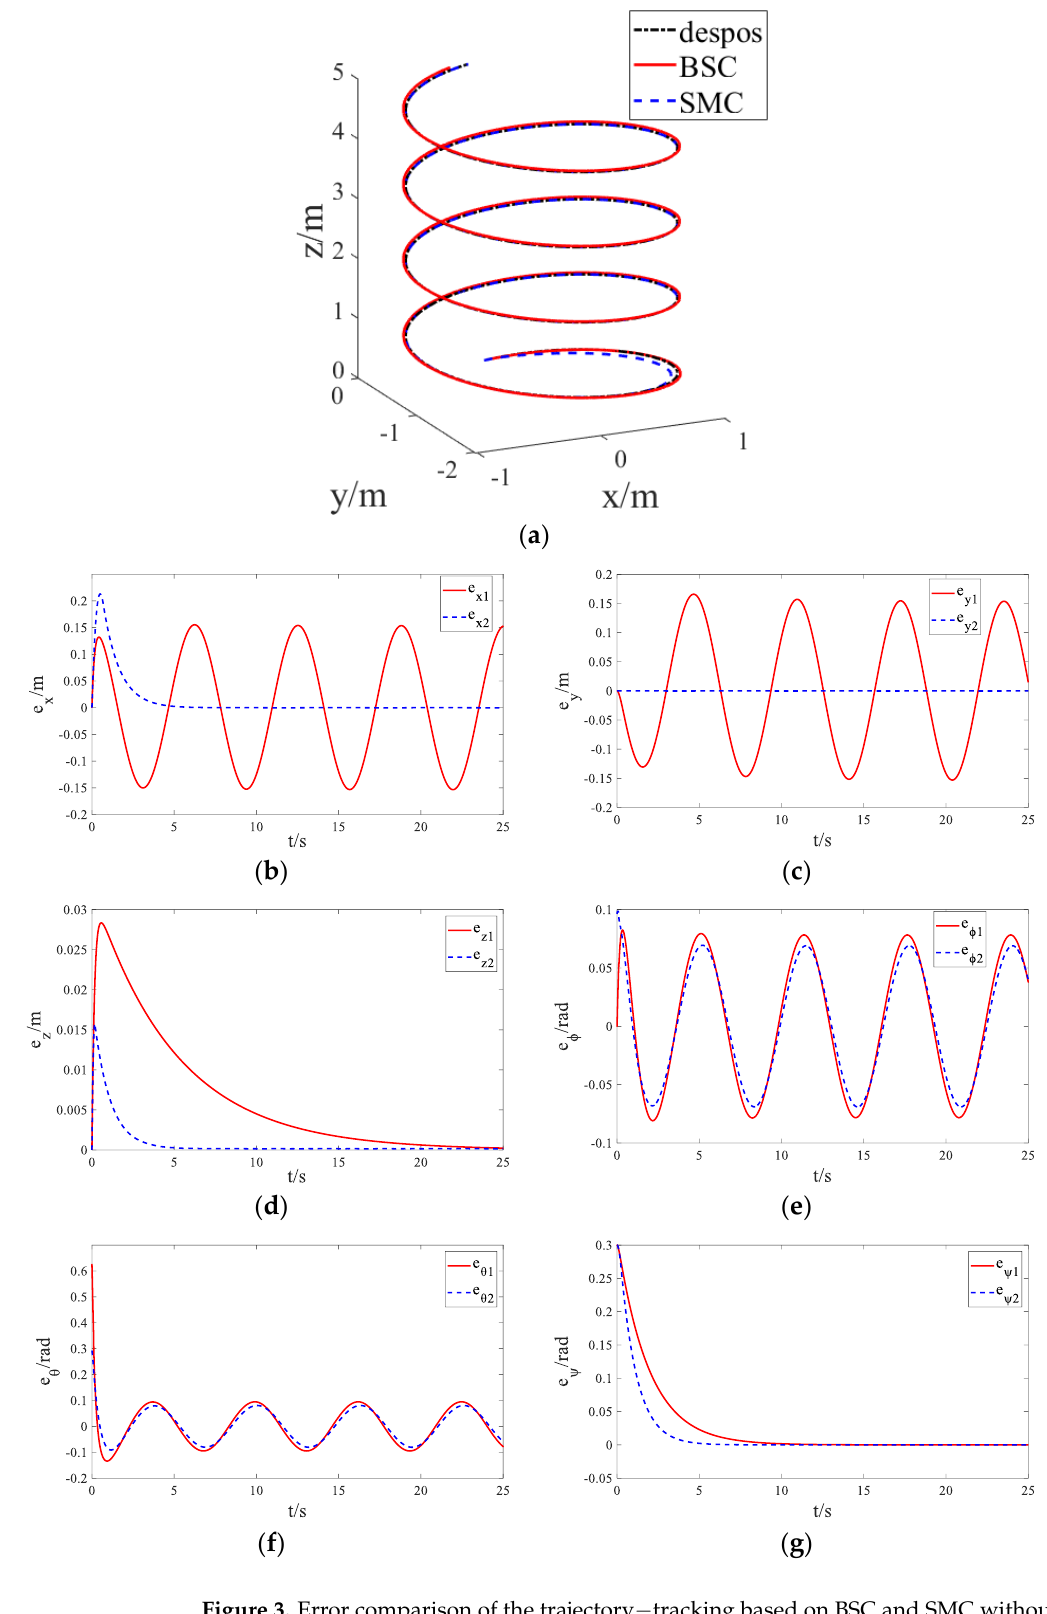
Figure 3. Error comparison of the trajectory − tracking based on BSC and SMC without disturbance: ( a ) 3D effect; ( b ) x trajectory; ( c ) y trajectory; ( d ) z trajectory; ( e ) roll angle; ( f ) pitch angle; and ( g ) yaw angle.